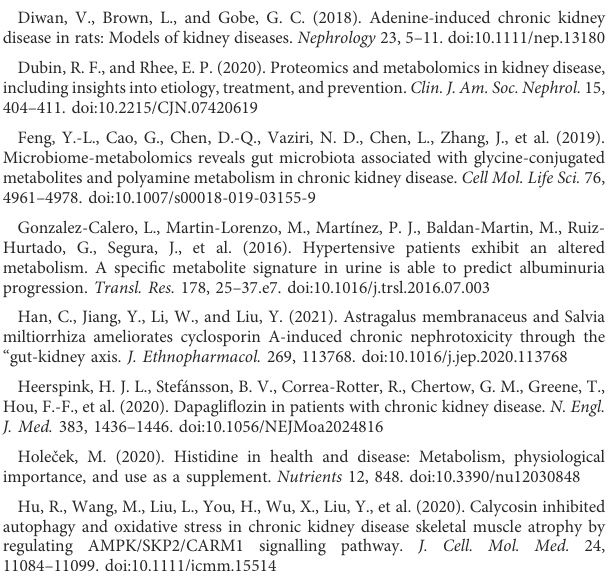
SUPPLEMENTARY FIGURE S1 The extracted ion chromatogram (EIC) of QC samples obtained from in positive (A) and negative (B) ion mode. SUPPLEMENTARY FIGURE S2 Permutation test of OPLS-DA model for N versus M in positive (A) and negative (B) ion mode. Permutation test of OPLS-DA model for M versus AMCZ in positive (C) and negative (D) ion mode. SUPPLEMENTARY TABLE S1 Signi fi cantly differentially expressed metabolites in the kidney of N versus M in positive ion mode. SUPPLEMENTARY TABLE S2 Signi fi cantly differentially expressed metabolites in the kidney of N versus M in negative ion mode. SUPPLEMENTARY TABLE S3 Signi fi cantly differentially expressed metabolites in M and AMCZ in positive ion mode. SUPPLEMENTARY TABLE S4 Signi fi cantly differentially expressed metabolites in M and AMCZ in negative ion